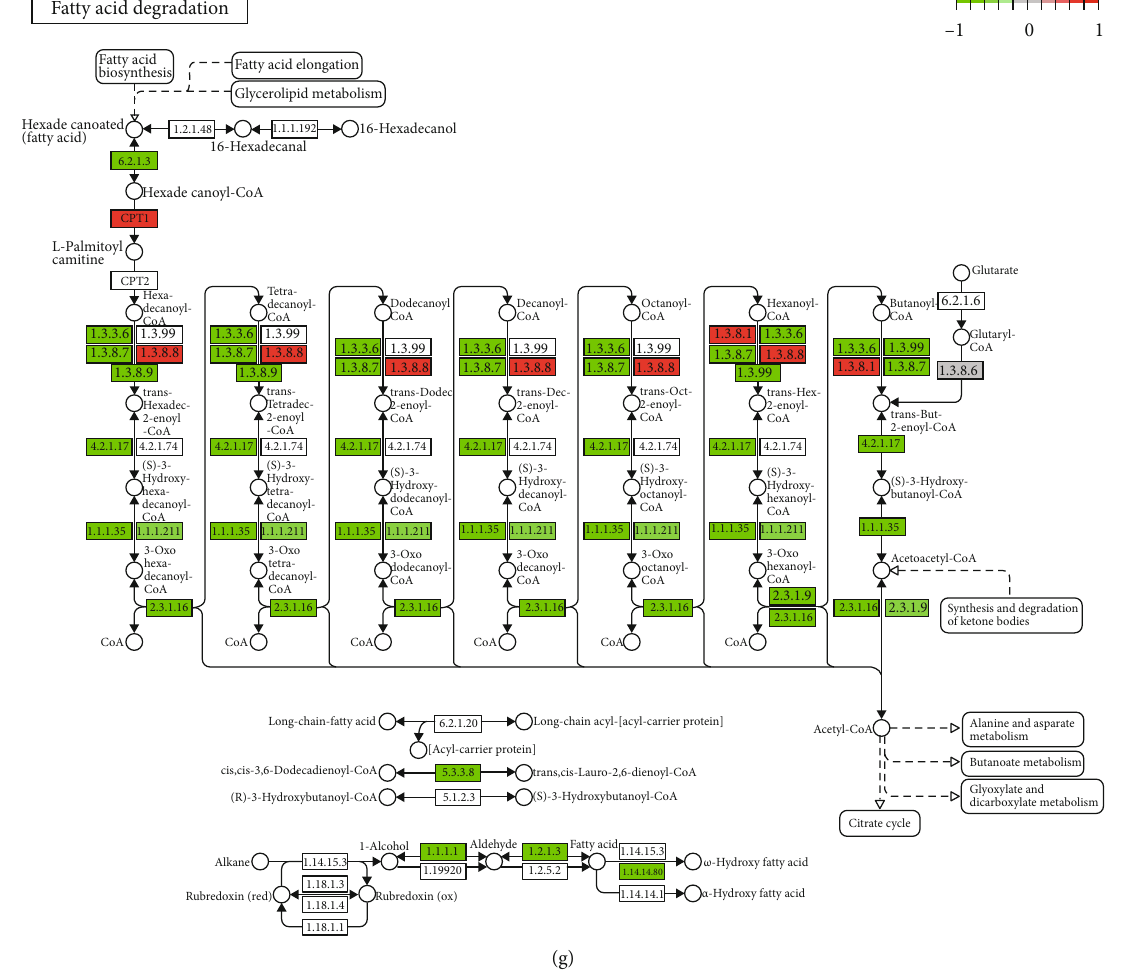
Figure 2: Overview of the fatty acid metabolism pathway in pan-renal cell carcinoma. (a) Venn diagrams of downregulated pathways in pan- renal cell carcinoma. (b) Venn diagrams of upregulated pathways in pan-renal cell carcinoma. (c) Interaction diagram between fatty acid metabolism genes. (d) The weight of each fatty acid metabolism gene in all the biological processes. The larger the value, the more critical is its biological role. (e) Inhibition or activation of related biological processes on fatty acid metabolism pathways in KIRC. (f) Inhibition or activation of relevant biological processes on fatty acid metabolism pathways in KIRP. (g) Inhibition or activation of related biological processes on fatty acid metabolism pathways in KICH. The redder the color, the more potent is the activation. The greener the color, the more in fl uential is the